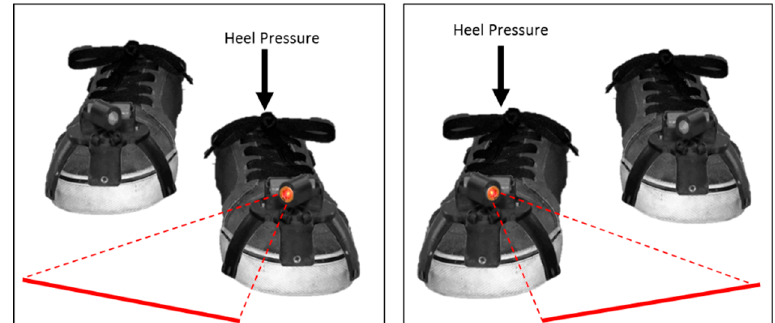
Figure 13. Illustration of the Laser Shoes, developed by Barthel et al. Each laser attachment projected a red laser line in front of the opposite foot when pressure was applied to the heel switch within the shoe.